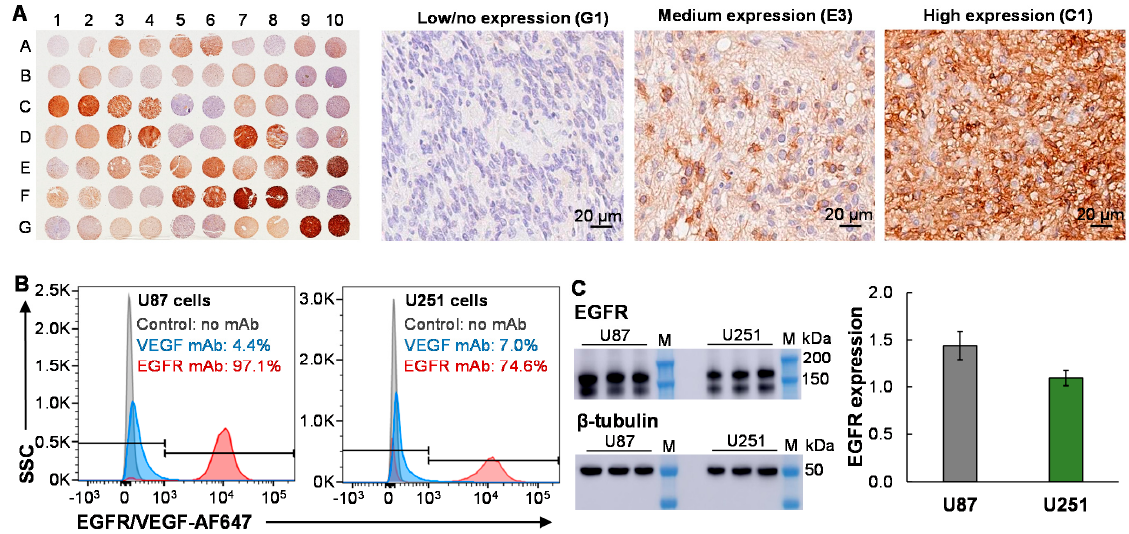
Figure 1. EGFR expression in GBM. ( A ) IHC staining of patient tissue microarray (TMA) to analyze EGFR surface expression in GBM (35 cases, 70 cores). Scale bar equals 20 µm. ( B ) Evaluation of surface binding rate of VEGF mAb-AF647 (blue) or EGFR mAb-AF647 (red) in GBM U87 and U251 cells by flow cytometry analysis. One million cells were stained with 1 µg of mAb-AF647 at room temperature for 30 min. ( C ) Western blotting analysis of EGFR in two GBM cell lines. 1: U87; 2: U251; and 3: